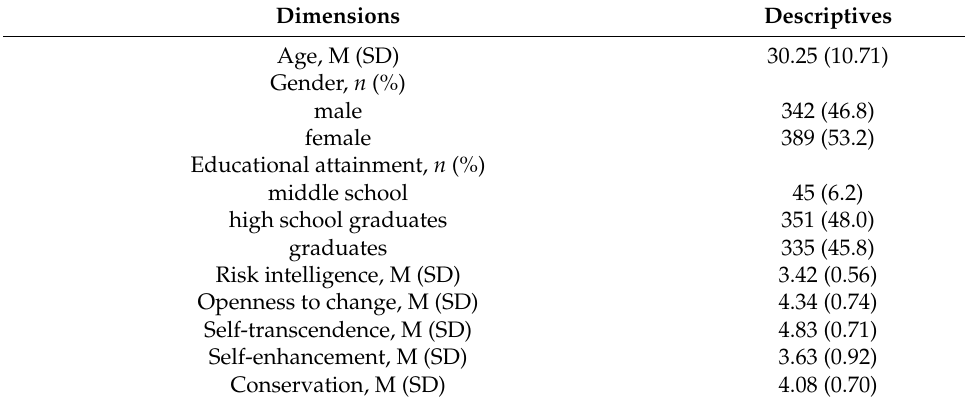
Table 1. Characteristics of the